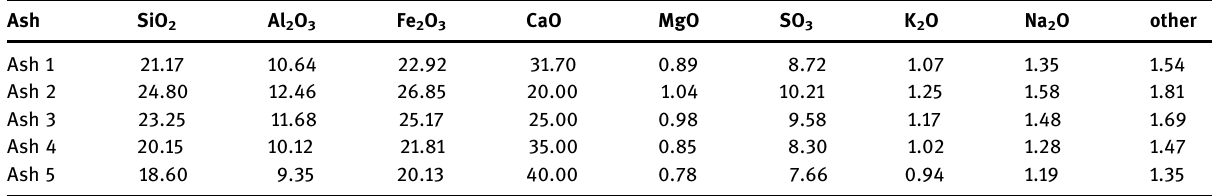
Table 3: Ash composition of di ff erent CaO content ( wt% ) Ash